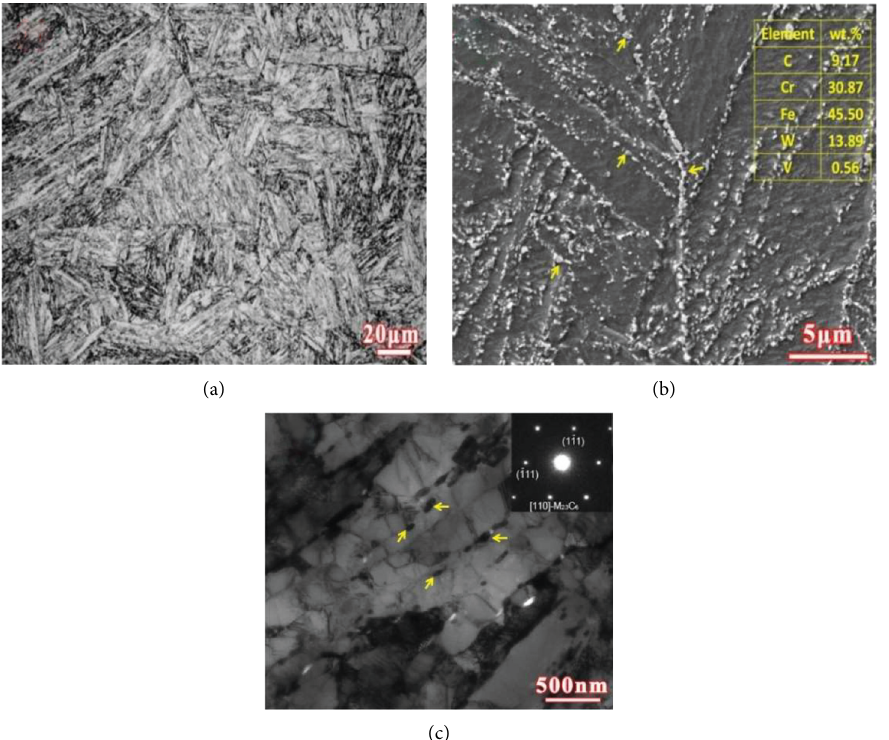
Figure 2: Microstructure images of as-received G115 steel. (a) Optical image. (b) SEM image. (c) TEM image.